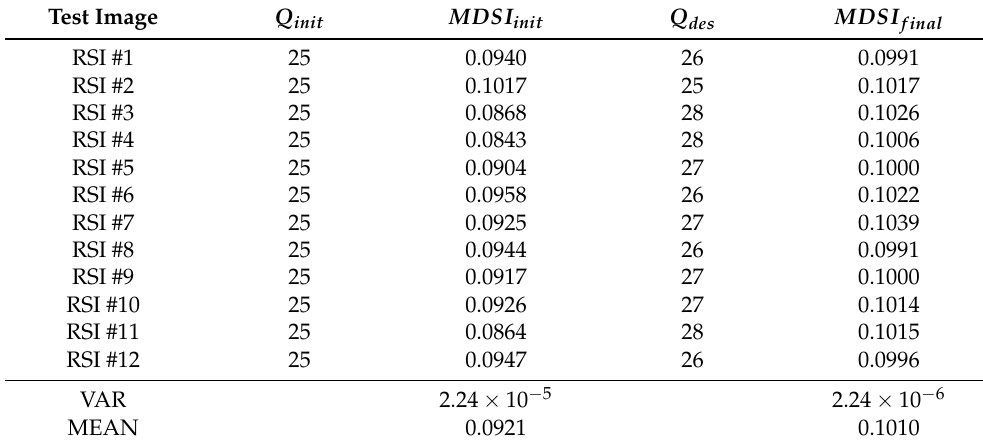
Table A3. The experimental data obtained for the basic image set for the desired MDSI = 0.1.